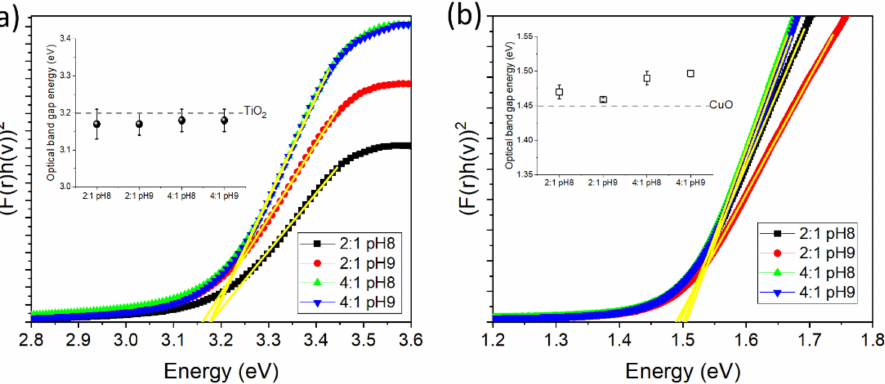
Figure 8. Curves of Kubelka–Munk function against absorbed light energy for the studied ( a ) TiO 2 and ( b ) CuO powders. In the insets, a plot of E g values as a function of the synthesis route for each oxide is shown. The dotted line in the inset of ( a ) indicates the theoretical value of bulk TiO 2 .